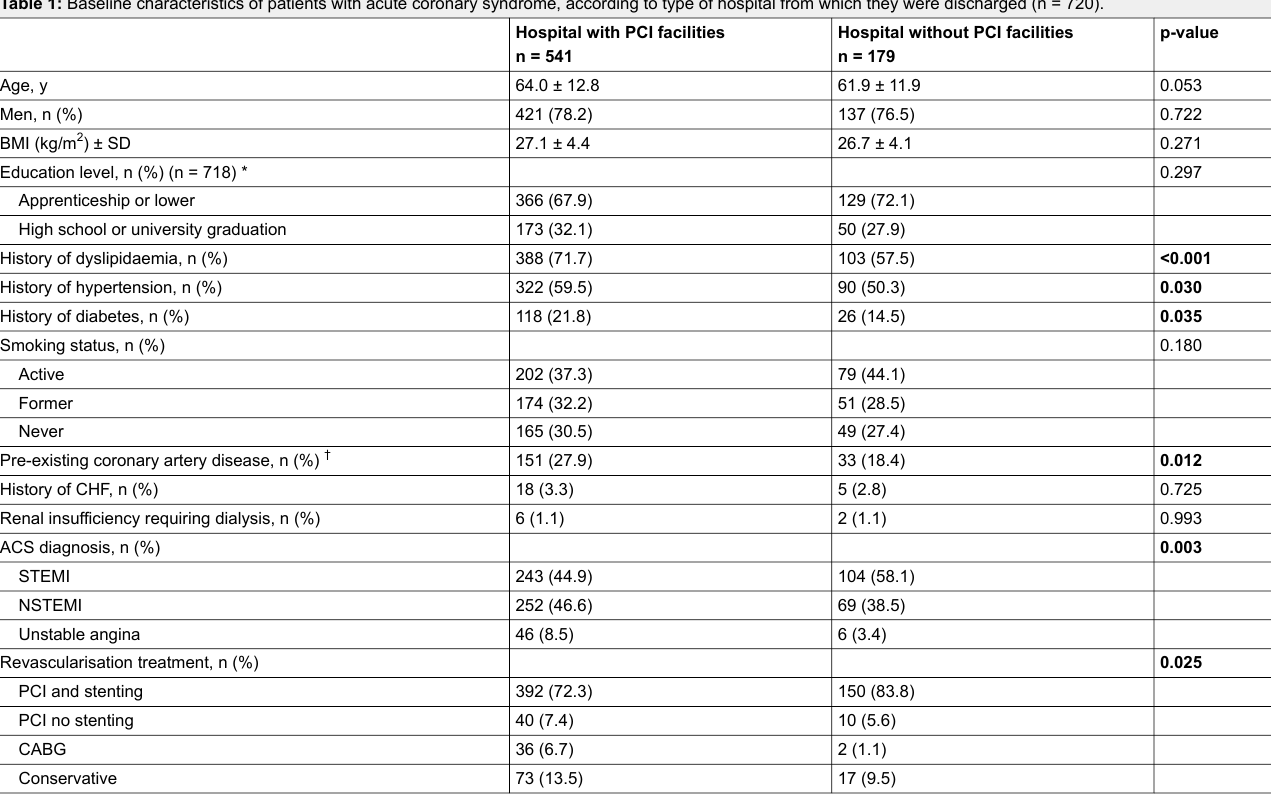
Table 1: Baseline characteristics of patients with acute coronary syndrome, according to type of hospital from which they were discharged (n =